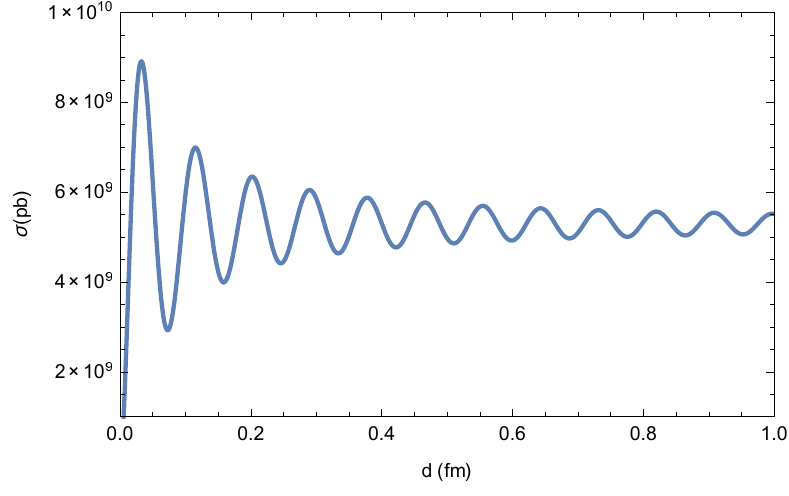
Figure 5. We show the magnitude of the total scattering cross section for a proton at 7 TeV in picobarn as a function of interpole distance parameter d in